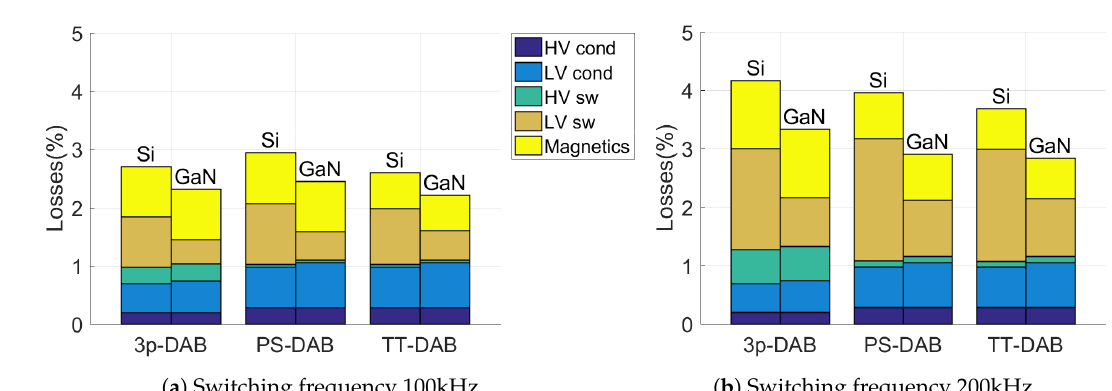
Figure 14. Average losses in % (converter losses divided by transferred power), including losses breakdown. DAB based topologies.GaN (EPC2206) vs Si (BSC026N08NS5) MOSFET